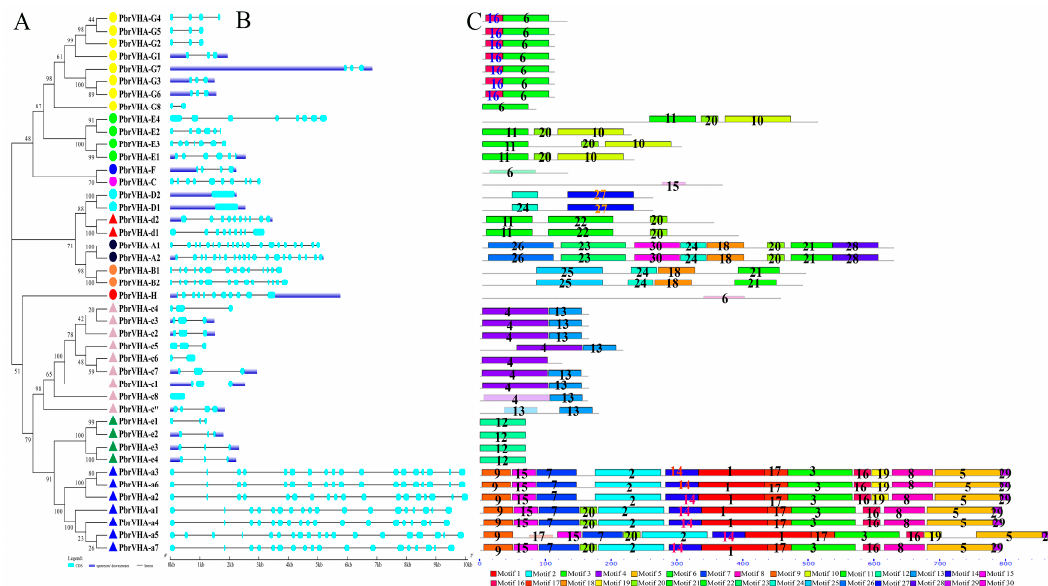
Figure 2. Structural and phylogenetic analyses of PbrVHA genes. ( A ) A phylogenetic tree based on sequences of the PbrVHA proteins was constructed using MEGA 6.0 ( B ) The intron–exon structures were depicted by Gene Structure Display Server 2.0. UTRs and exons are represented by blue and light blue boxes, respectively, and introns are represented by grey lines. ( C ) Distribution of conserved motifs of PbrVHA proteins was described by Motif-based sequence analysis tools. Different motifs are indicated by different colours and numbered from 1 to 30; black lines represent non-conserved sequences.